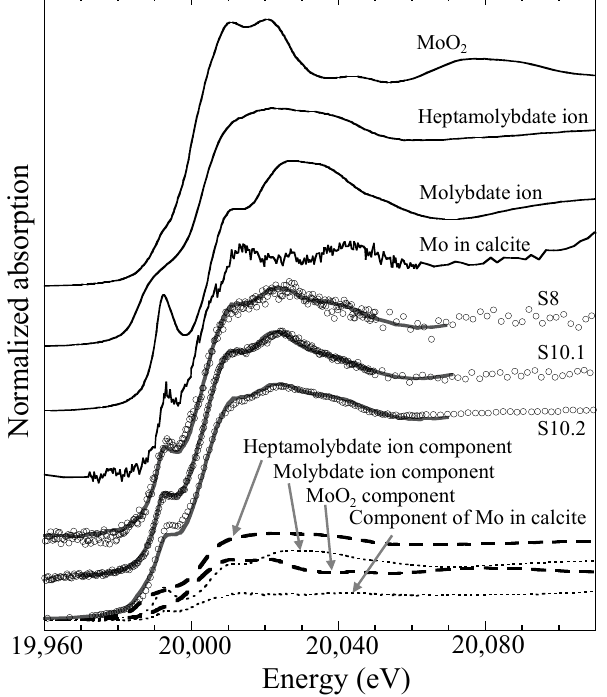
Figure 4. Mo K-edge XANES spectra for samples (S8, S10.1, and S10.2) and reference materials (MoO 2 , heptamolybdate ion in water, molybdate ion in water, molybdate ion adsorbed on ferrihydrite and MoS 2 ). Fitting results for the samples are shown as bold curves. Deconvolution results for S10.2 are given by showing the contributions of the three reference materials. Table 3. Proportion of molybdate on ferrihydrite, heptamolybdate and MoO 2 by Mo K-edge XANES. Molybdate on Ferrihydrite (%) Heptamolybdate